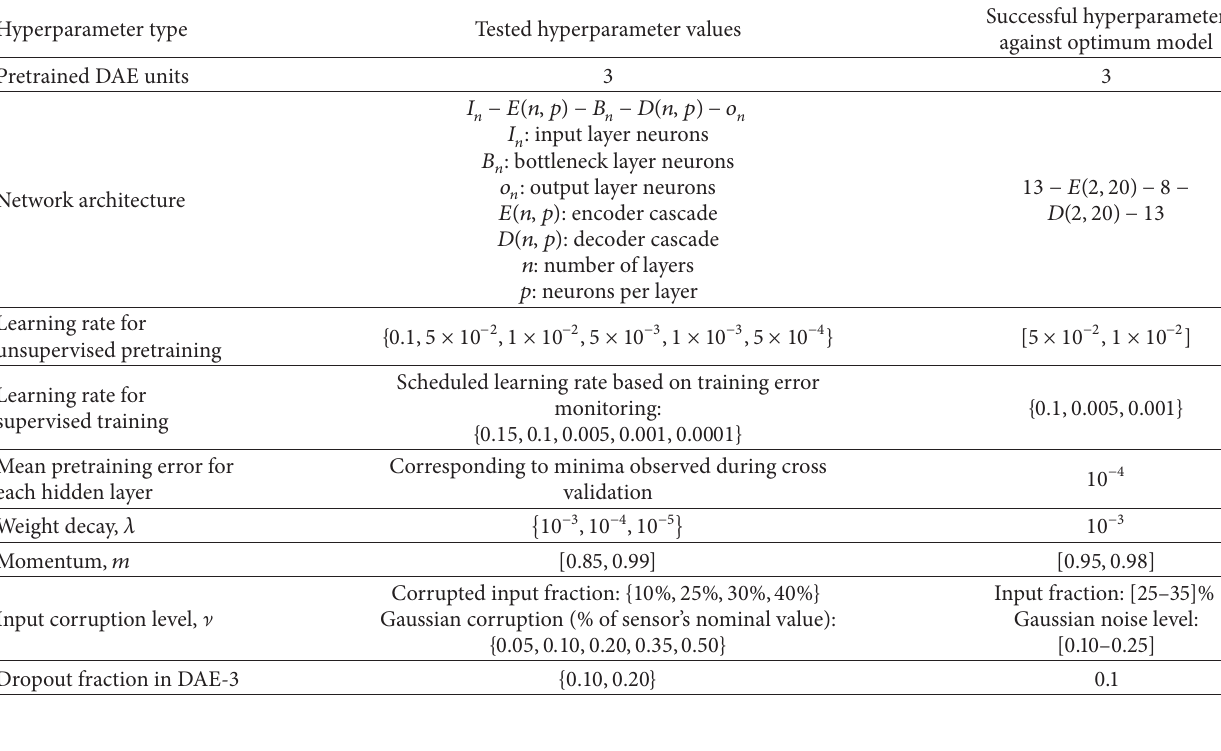
Table 2: Summary of DAASM